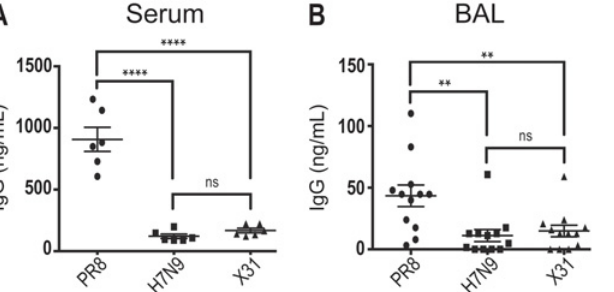
Fig 2. Limited antibody cross-reactivity between PR8 and H7N9 influenza viruses. (A) Concentration of anti-PR8, anti-H7N9, and anti-X31 specific IgG antibody levels in the serum of mice previously infected with PR8 and rested to immunological memory. N = 6; mean and standard error of the mean displayed. (B) Concentration of anti-PR8, anti-H7N9, and anti-X31 specific IgG antibody levels in the supernatant of a bronchoalveolar lavage (BAL) from mice previously infected with PR8 and rested to immunological memory. N = 12; mean and standard error of the mean displayed. Statistics: One-way ANOVA was used to compare concentrations of cross-reactive IgG, multiple comparisons, with correction, were evaluated for significance by Tukey ’ s test; p-values { ** < 0.01; **** < 0.0001}.